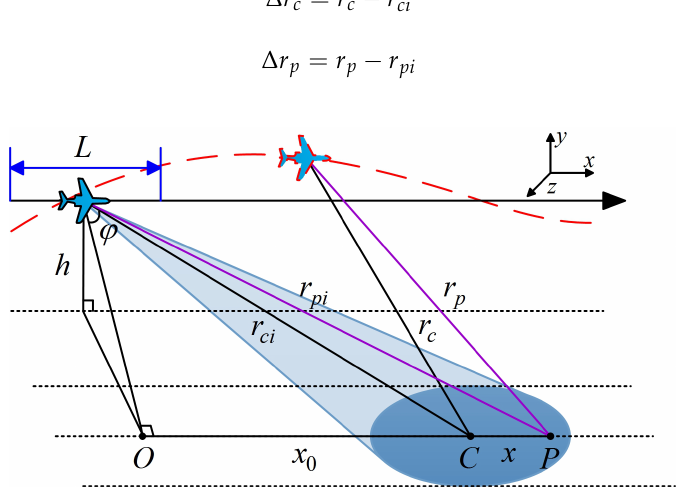
Figure 1. An illustration of Synthetic Aperture Radar (SAR) imaging